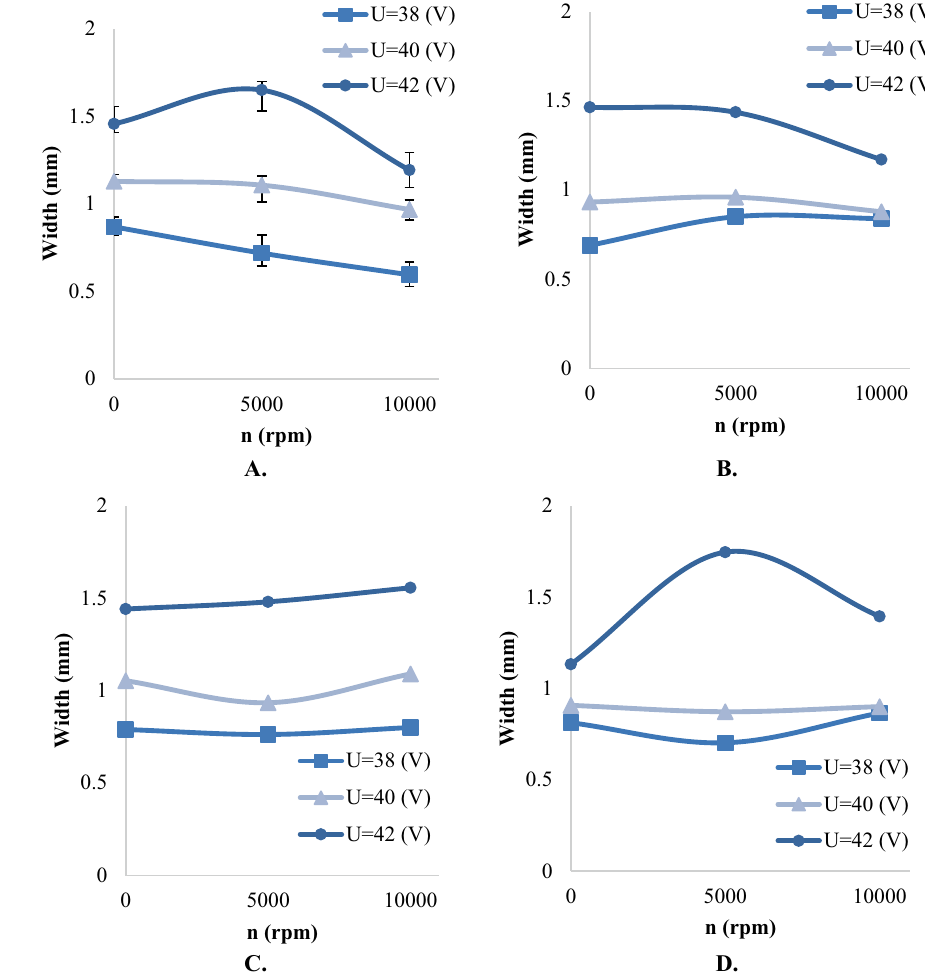
Fig. 11 Effect of machin- ing voltage and rotational speed on microchannel width in different conditions. a V = 1.2 mm/min - NaOH-30%. b V = 0.6 mm/min - NaOH-30%. c V = 1.2 mm/min - NaOH-25%. d V = 0.6 mm/min -